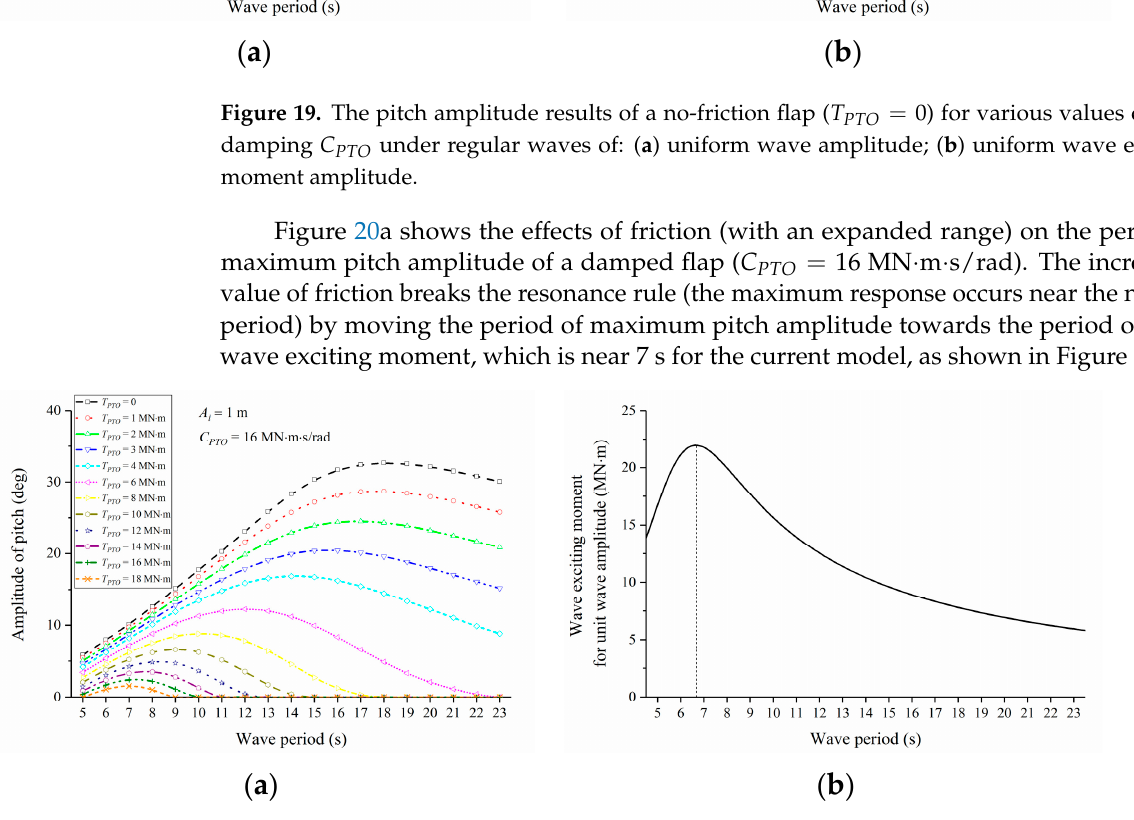
Figure 20. ( a ) The pitch amplitude results for a damped flap ( C PTO = 16 MN · m · s/rad) with various values of PTO friction T PTO under unit-amplitude regular waves; ( b ) wave exciting moment for unit wave amplitude.